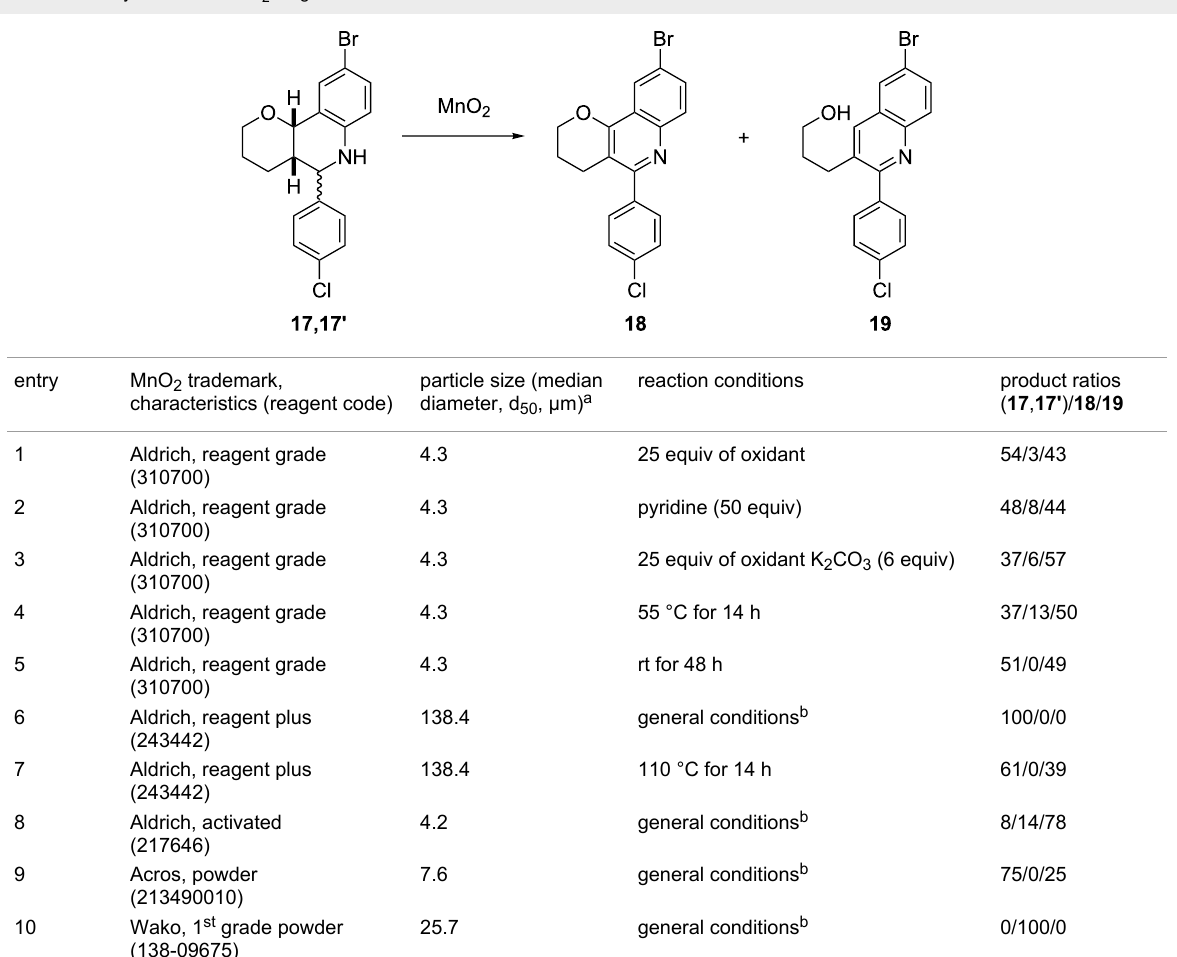
Table 1: Survey of different MnO 2